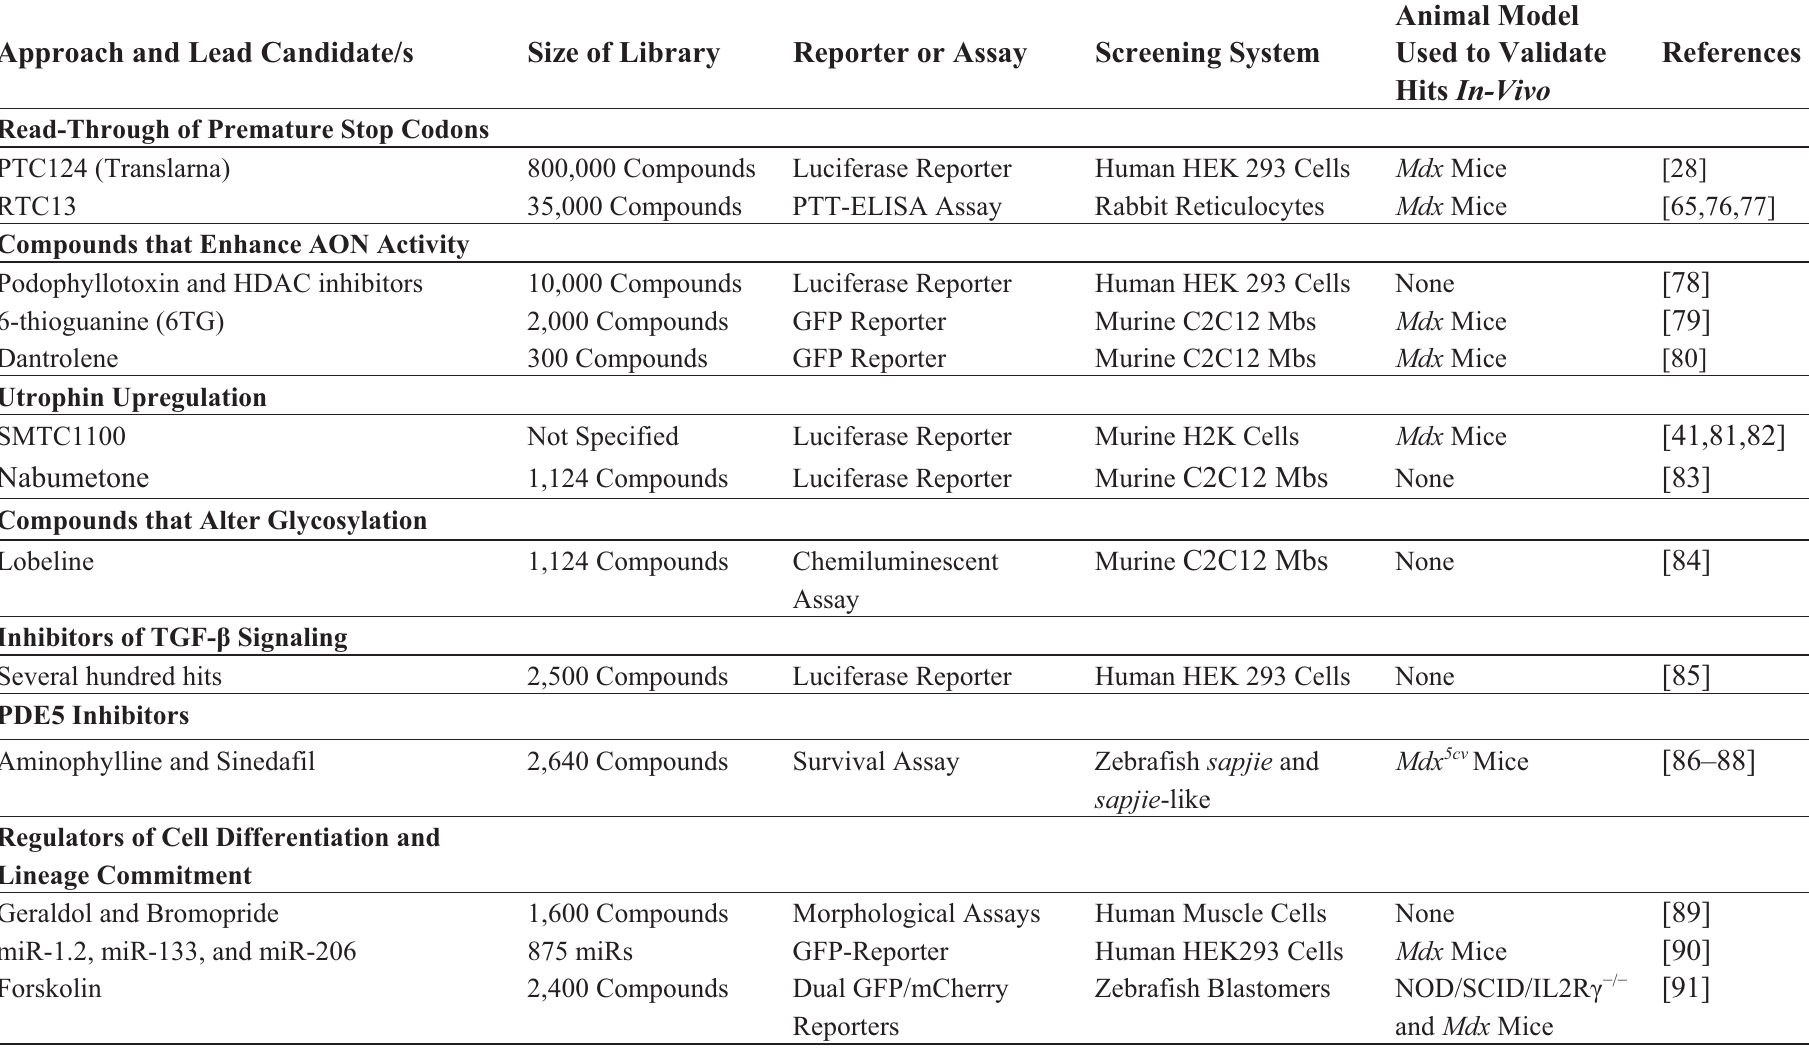
Table 1. Therapeutic drugs to DMD identified through